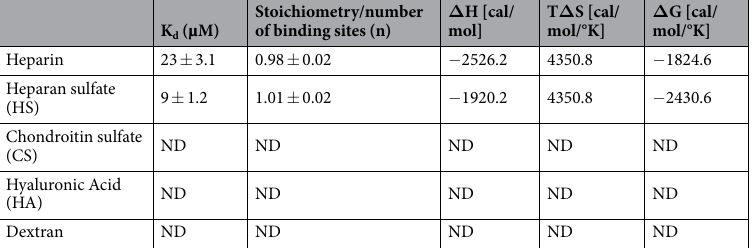
Table 1. Binding parameters of various GAGs interacting with IL-12 derived from ITC analysis. * ND - not